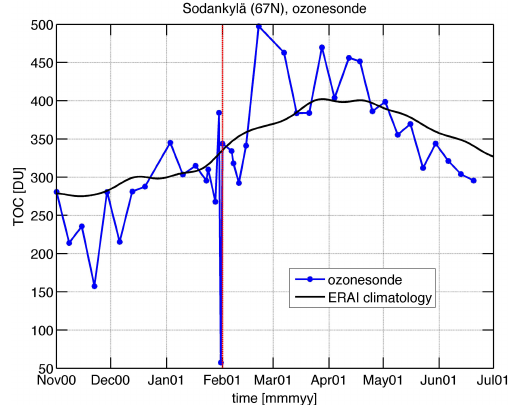
Figure 3. Total ozone derived from ozonesondes (blue line) launched at Sodankyla (67 ◦ N). High TOC values ( > 450DU) are reached after the SSW of February 2001 (red line), similar as in the composite of Fig. 2. The black line denotes the long-term mean at Sodankyla as derived from the ERA Interim reanalysis (1979– 2014).